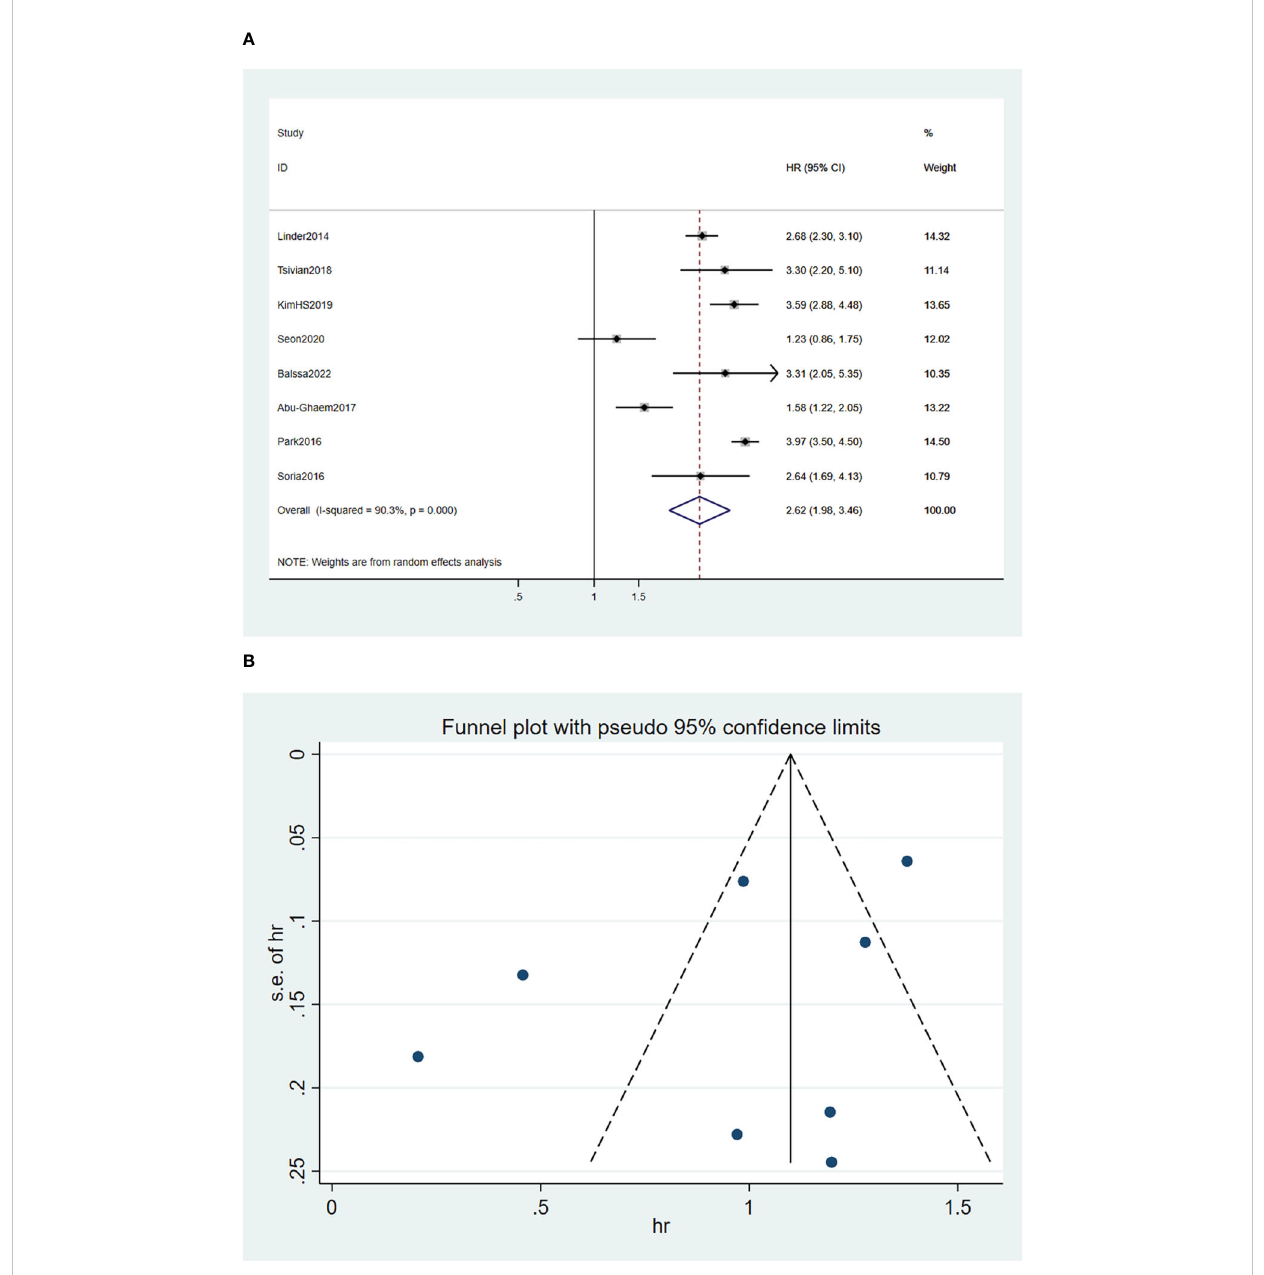
FIGURE 2 Forest plot (A) and funnel plot (B) depicting the association between PBT and overall survival. HR values greater than 1 indicate that the intervention is detrimental to survival, implying that PBT was associated with poorer